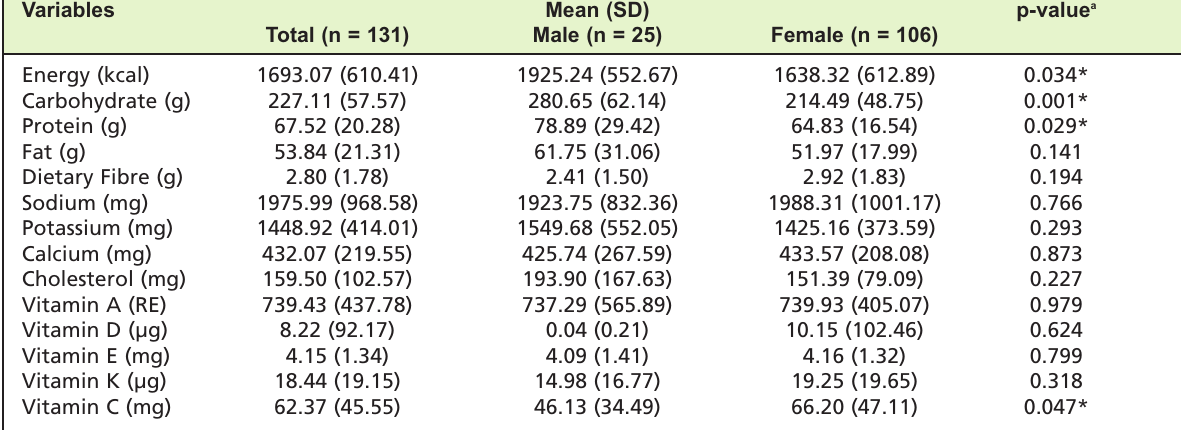
Dietary intake according to gender (n = 131) Table III: